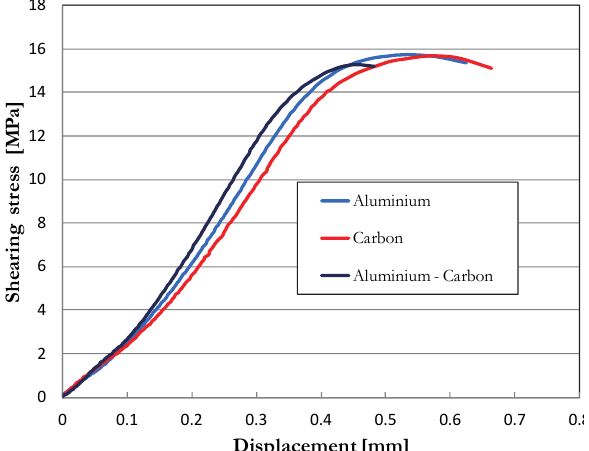
Figure 10: Relative shearing displacements for adherends of 5